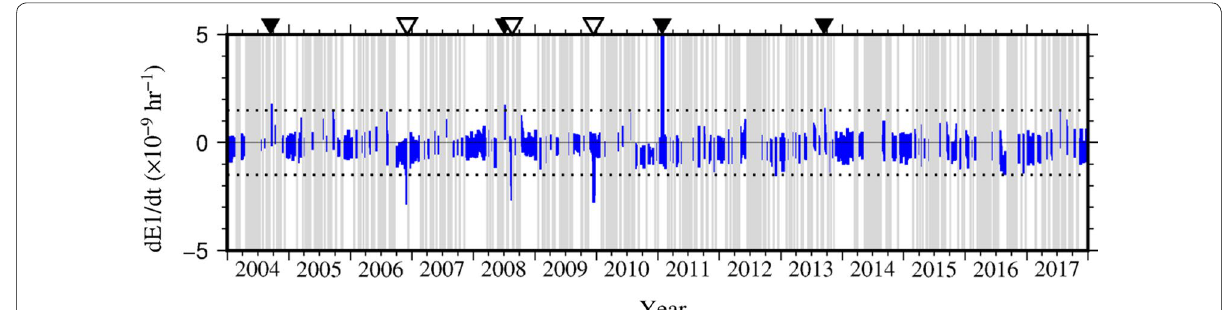
Fig. 6 Strain change rate on component E1 at station ISA, 2004–2017. The strain change rate is defined as the time derivative of the 24-h moving average of the original time series. Gray shadows correspond to time periods in which significant precipitation (> 40 mm/h) was observed in the previous week, which likely affects strain data. Open (positive) and solid (negative) inverted triangles indicate strain rates that exceed the threshold levels of 1.5 × 10 − 9 day − 1 (dotted lines). The threshold value is half the strain rate at the beginning of the edifice inflation that led to the major eruption in